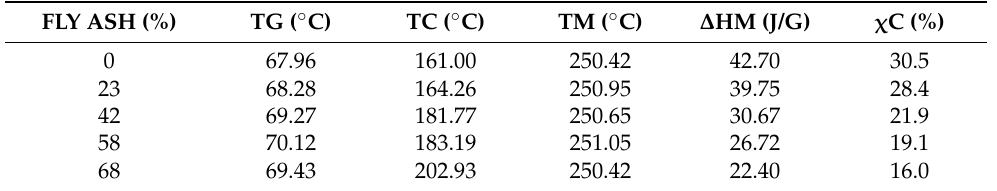
Table 1. Thermal profile of the composite material rPET–fly